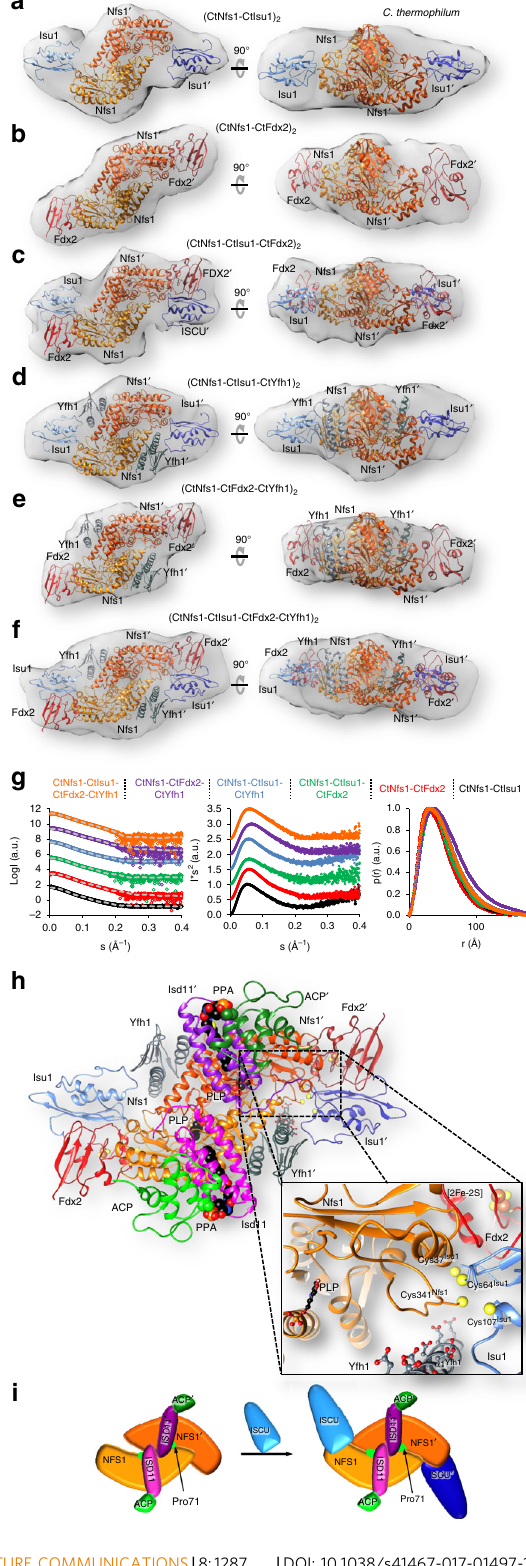
Fig. 6 SAXS shapes of various C. thermophilum ISC complexes. a – c CtNfs1 (orange) was incubated with CtIsu1 (blue), CtFdx2 (red) or both in 1:1 or 1:1:1 ratios. The NFS1-ISCU crystal structure was fi tted to the obtained density a . Ab initio fi tting of FDX2 together with NFS1 into the density resulted in a distinct complex b . Both complexes were combined to be fi t into the density obtained for the hetero-hexameric complex c . d , e , Upon addition of CtYfh1 (slate gray) to the CtNfs1-CtIsu1 or CtNfs1-CtFdx2 complexes in a 1:1:1 ratio, complex formation could be observed from the respective SAXS density. The NFS1-ISCU crystal structure was used for ab initio fi tting of the positions of NFS1, ISCU, and FXN in the obtained density d . To fi t NFS1, FDX2, and FXN ab initio into the SAXS density, results from b and d were combined e . f Mixing of CtNfs1-CtIsu1-CtFdx2-CtYfh1 yielded an octameric complex. Ab initio fi tting into the SAXS densities made use of the above complexes. g Scattering curves with respective fi ts in gray (left), Kratky plots (middle), and pair distribution plots (right) as in Fig. 5. h Model of the entire ISC complex based on the crystal and SAXS data. The inset shows the active sites of NFS1, ISCU, FDX2, and FXN. PLP of NFS1 is